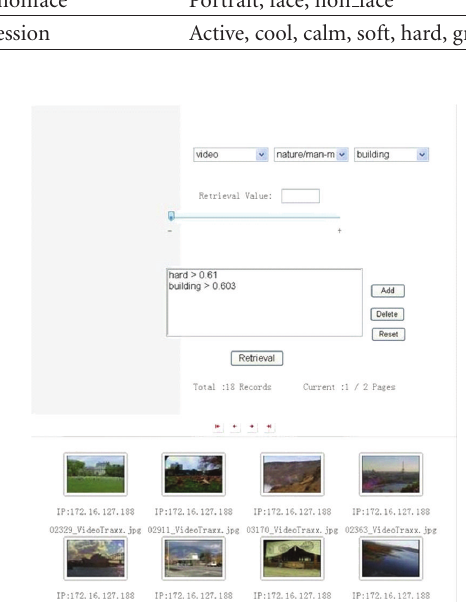
Figure 5: System